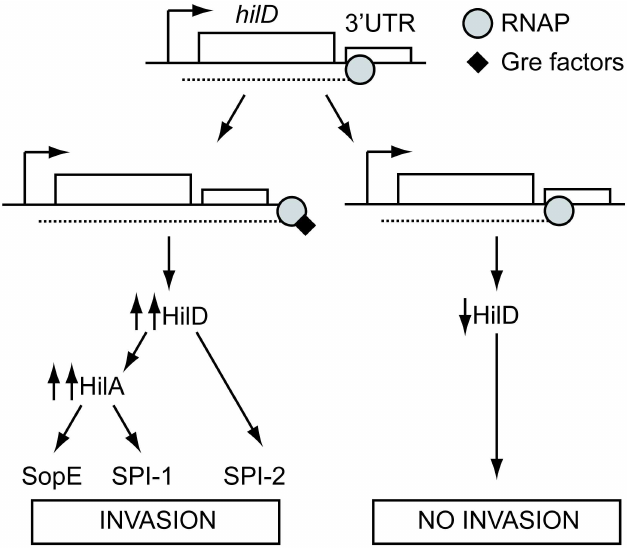
Fig 8. Summary of the effectsof Gre factor deficiency in the expression of virulence in S . Typhimurium.